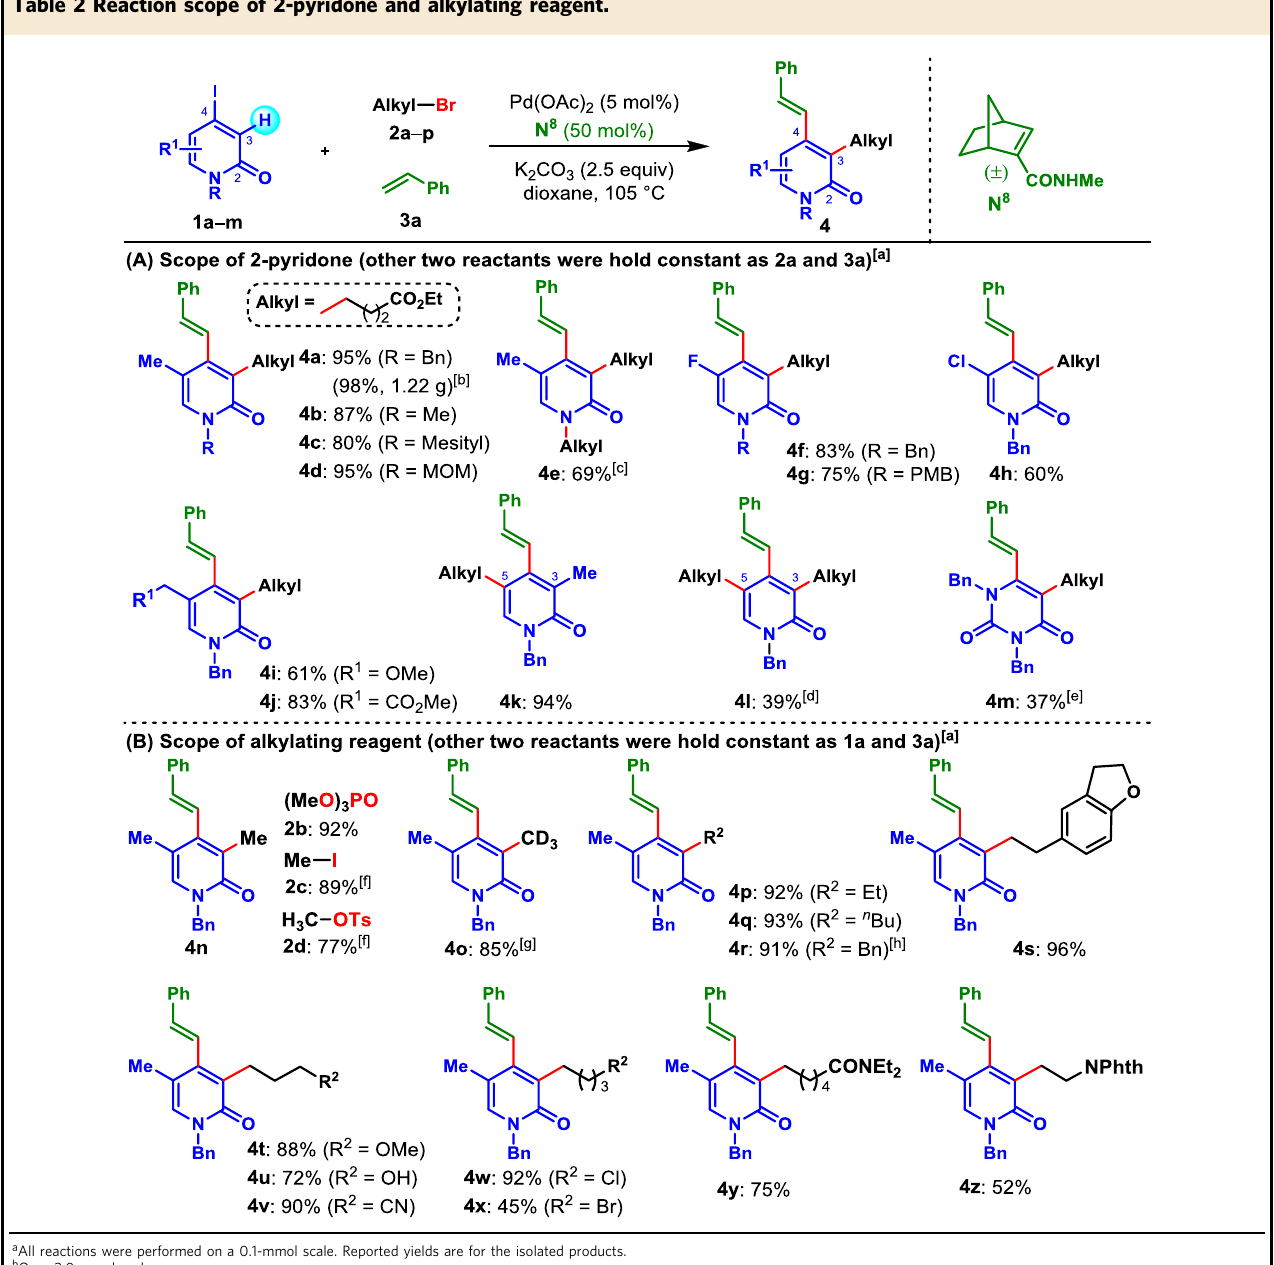
Table 2 Reaction scope of 2-pyridone and alkylating